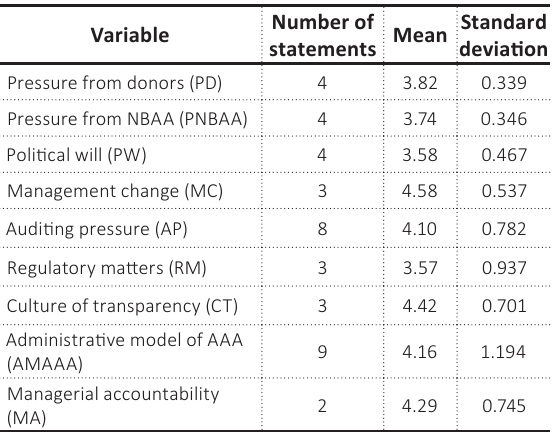
Table 2. Descriptive statistics of data